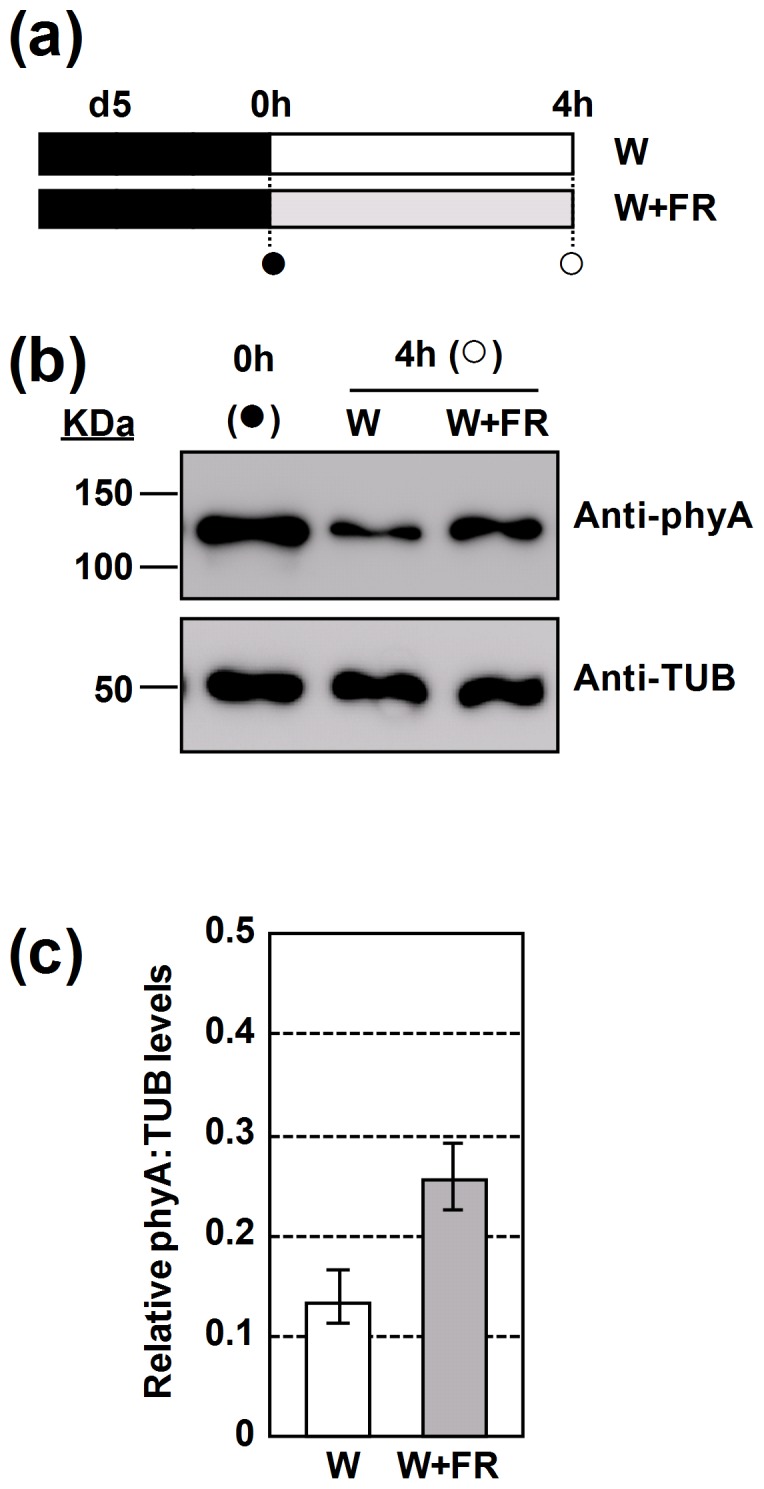
Phytochrome A is stabilized by white light of very low R:FR.(a) phyA levels were assayed in extracts from Col-0 seedlings grown in darkness for 5 days and then either transferred to W or W+FR for 4 hours. Circles indicate the harvest time of the plant material. (b) Representative steady-state levels of phyA (upper panel) and tubulin (TUB, lower panel) in extracts from seedlings grown as indicated in a,. Bands were detected by immunoblot using the phyA-specific mAb 073D or a TUB-specific mAb. TUB was used as a loading control. (c) Relative levels of phyA normalized to TUB in seedlings differentially grown for 4 h under W or W+FR, as indicated in a; n = 3 independent biological replicas; the P-value between the W and W+FR treated samples was 0.053.